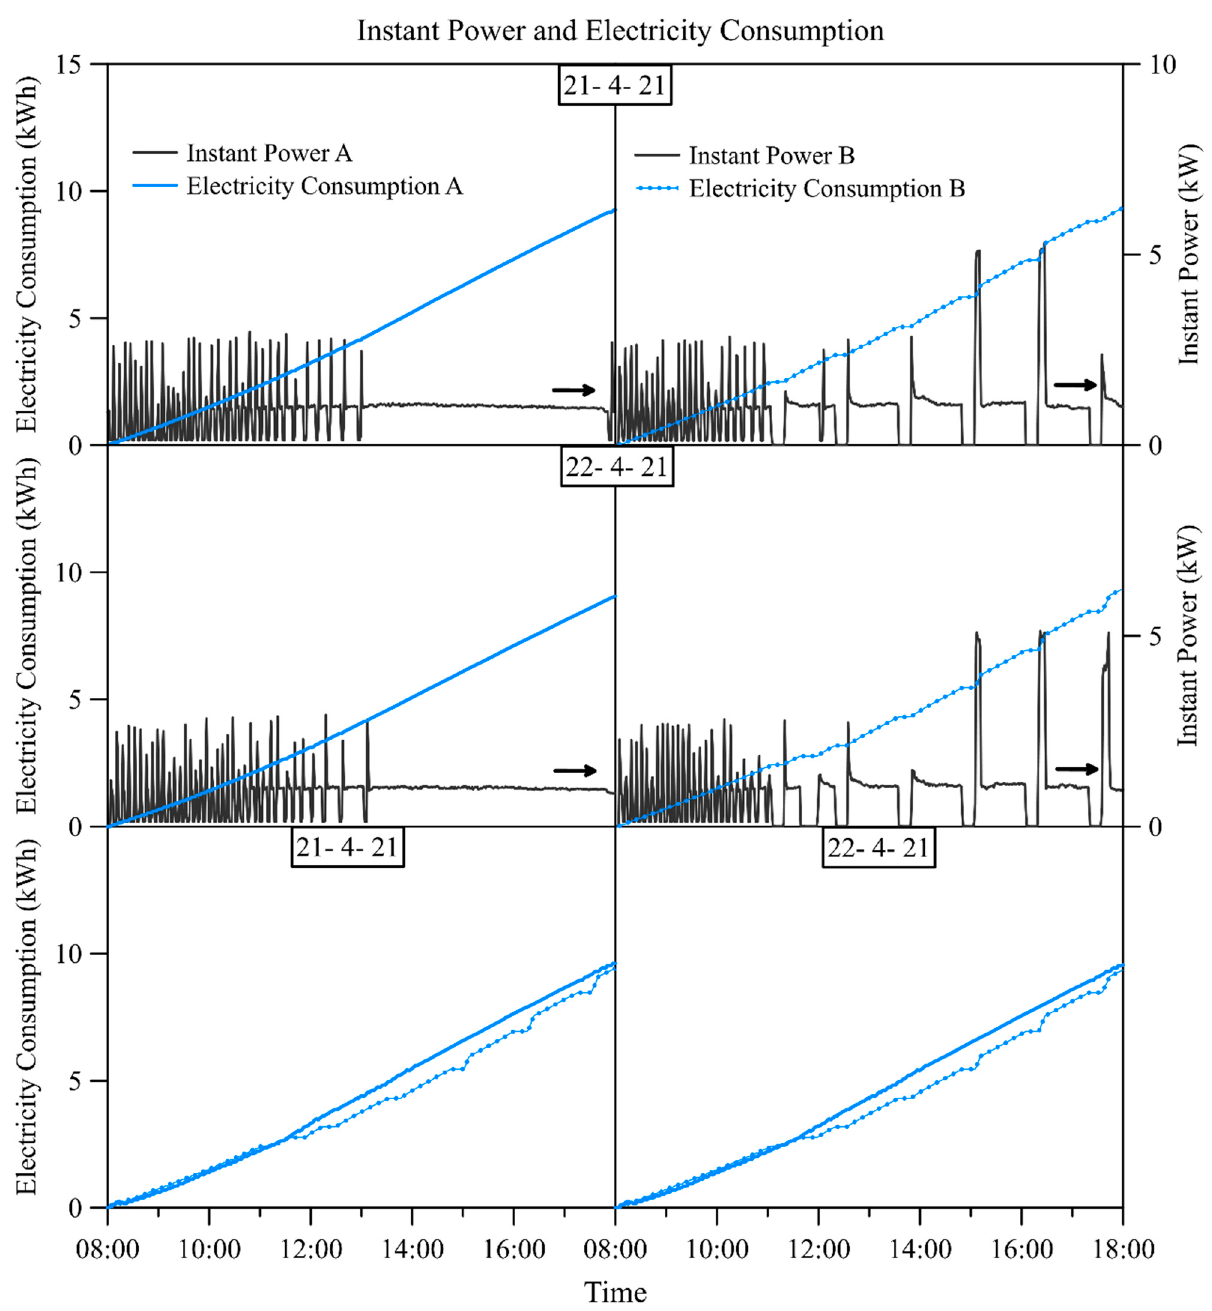
Figure 12. Instant power and electricity consumption of rooms A and B.